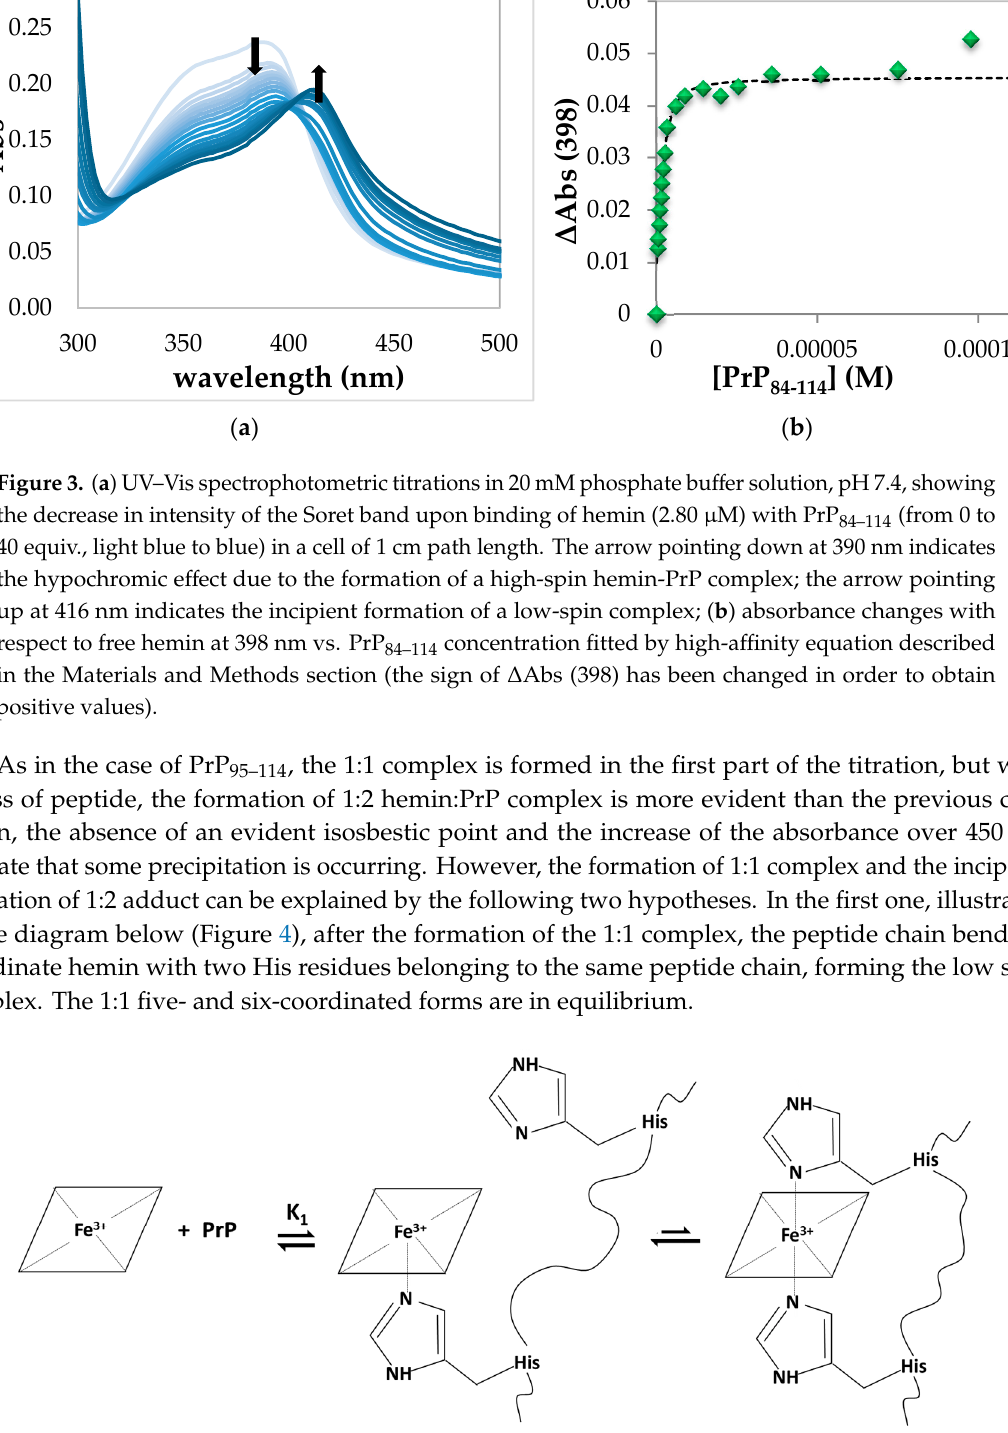
Figure 4. Schematic representation of the formation of 1:1 complex with possible equilibrium between five- and six-coordinated species. The peptide chain of a single peptide can coordinate hemin with two histidine residues at the same time; in the 1:1 complex five- and six-coordinated species are in equilibrium.